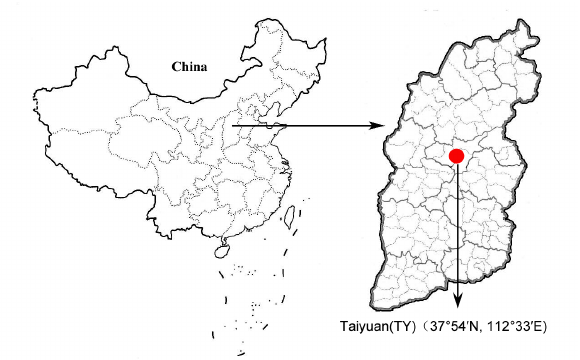
Fig. 1: Location of the study area in Taiyuan (TY), Shanxi, China (filled